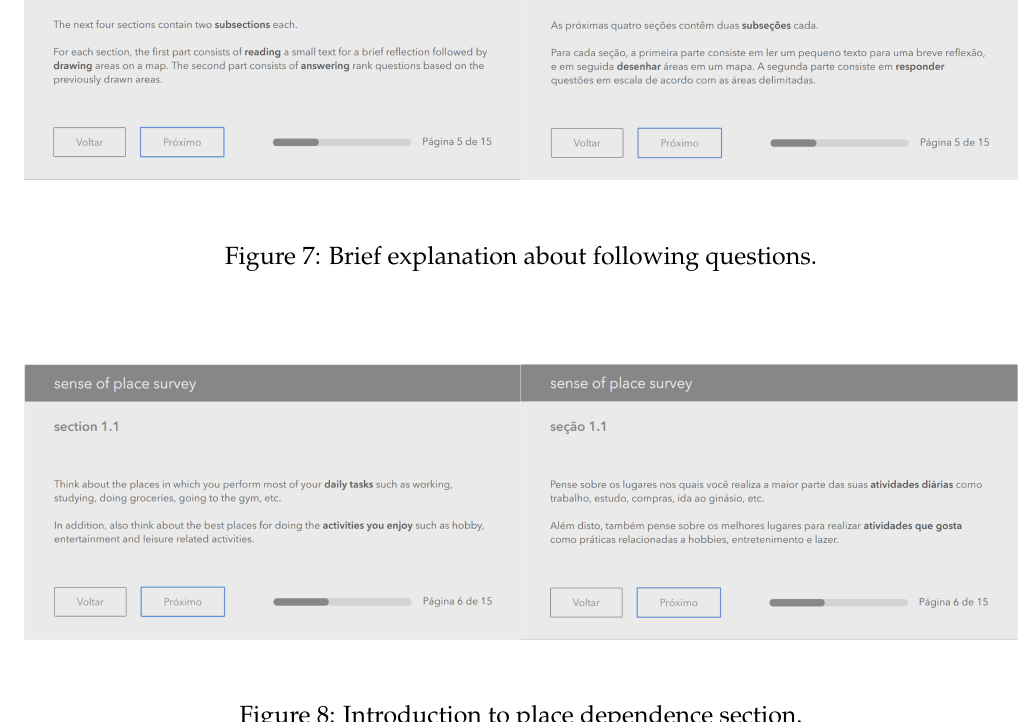
Figure 8: Introduction to place dependence section.